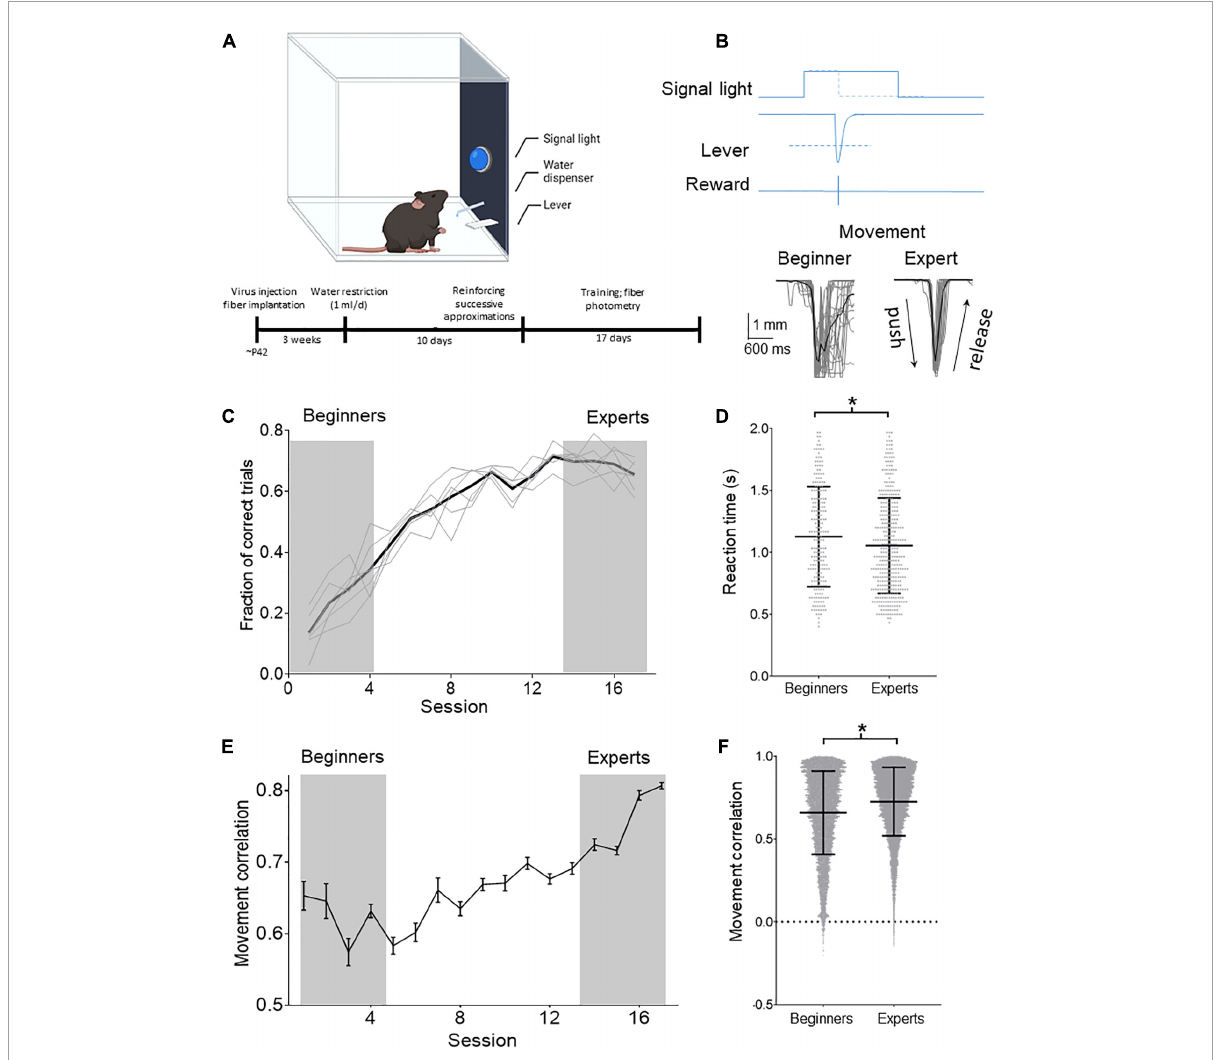
FIGURE2 Operant learning in freely moving mice. (A) Schematic drawing of the task in which the animals learn to obtain the reinforcer in an operant conditioned manner. Below is shown the timeline with the experimental procedures. (B) Behavioral task: the animals learned to press the lever in response to a cue (signal light). The cue remained ON for 2 s, and the animals had to press the lever during this time to receive a reward (drop of water). When the lever reached a threshold (dashed line; 3 mm) to deliver the reward, the signal light was immediately turned OFF. The position of the lever was tracked with a video camera and digitized offline (gray traces). The lever positions of all the trials obtained in two sessions (one at the beginning of training and one when mice become experts) of one of the experimental animals are illustrated below (average black line). (C) Mean (black line) and individual temporal course (gray lines) of the proportion of correct lever pressings in relation to all the pressing performed by the animals per session. (D) Reaction times computed for individual trial computed for the first four (beginners) and last four training sessions (experts). Mean ± SD reaction times are shown. (E) Temporal course of Pearson’s correlation computed for all the trajectories performed by the animals during the session. (F) Distribution of movement trajectory correlations (lines indicate mean ± SD) computed for the first four (beginners) and last four training sessions (experts). * p < 0.05 Mann–Whitney